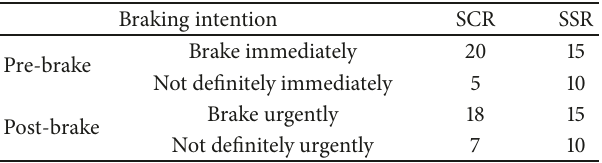
Table 9: Summary of drivers’ answers to postsimulation question-